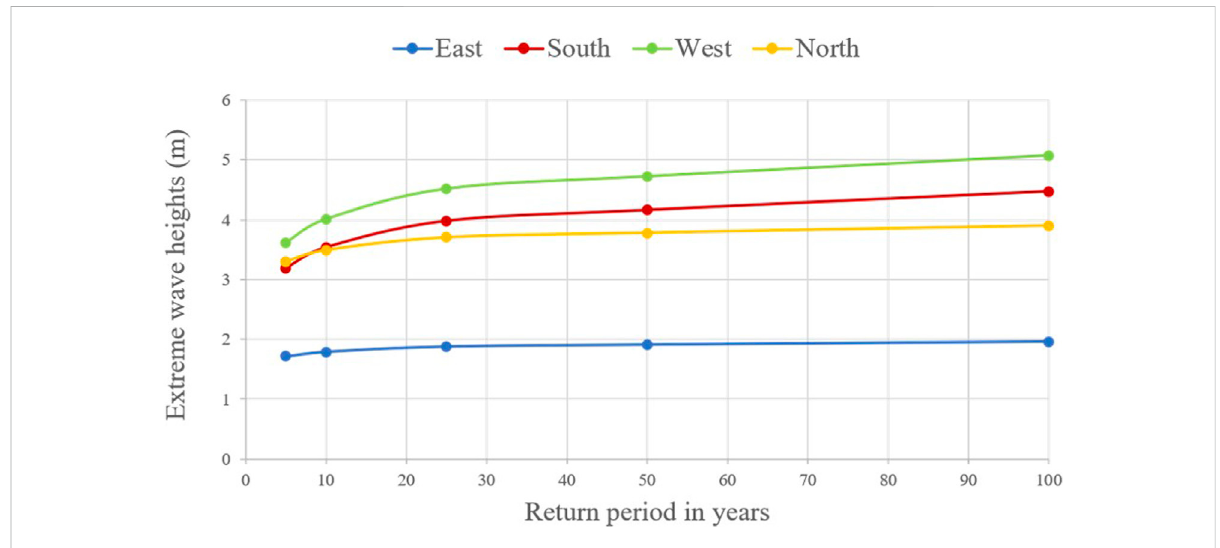
FIGURE 15 Extreme wave height values based on extreme wave heights vs. return periods at North, South, West and East zone of Agatti